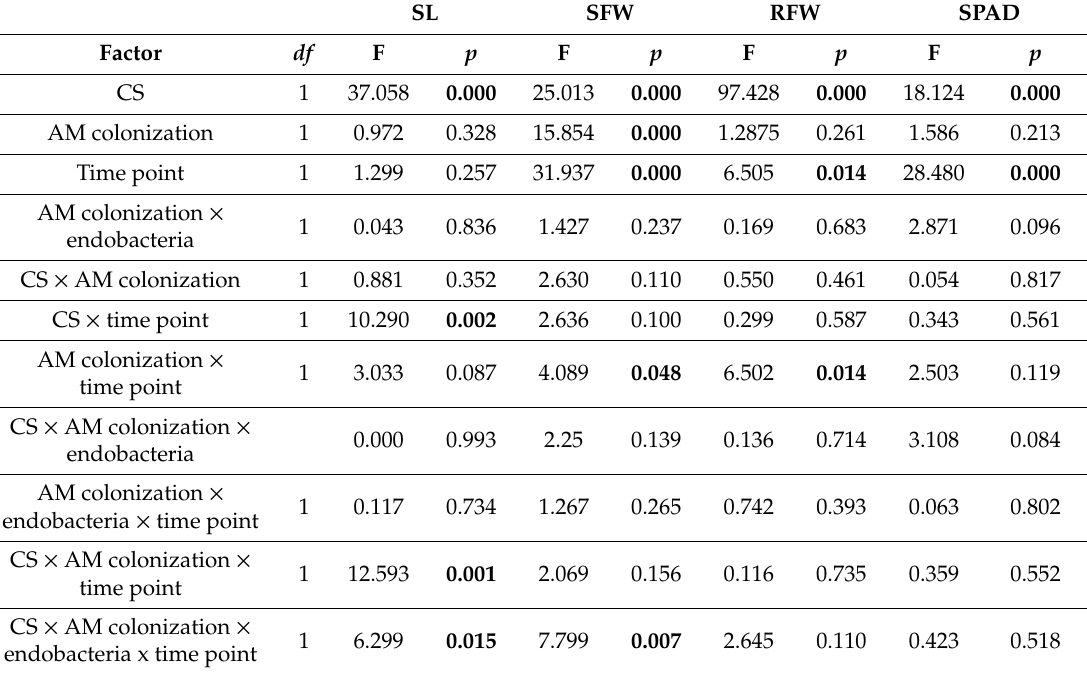
Table 1. Four-way ANOVA table on plant growth traits data (model formula: parameter ~ treatment × (AM colonization / endobacteria) × time point). SL, shoot length, SFW, shoot fresh weight, RFW, root fresh weight, SPAD index. Significant factors’ e ff ects and their interactions ( p < 0.05) are shown in bold. CS, combined water / nutrient